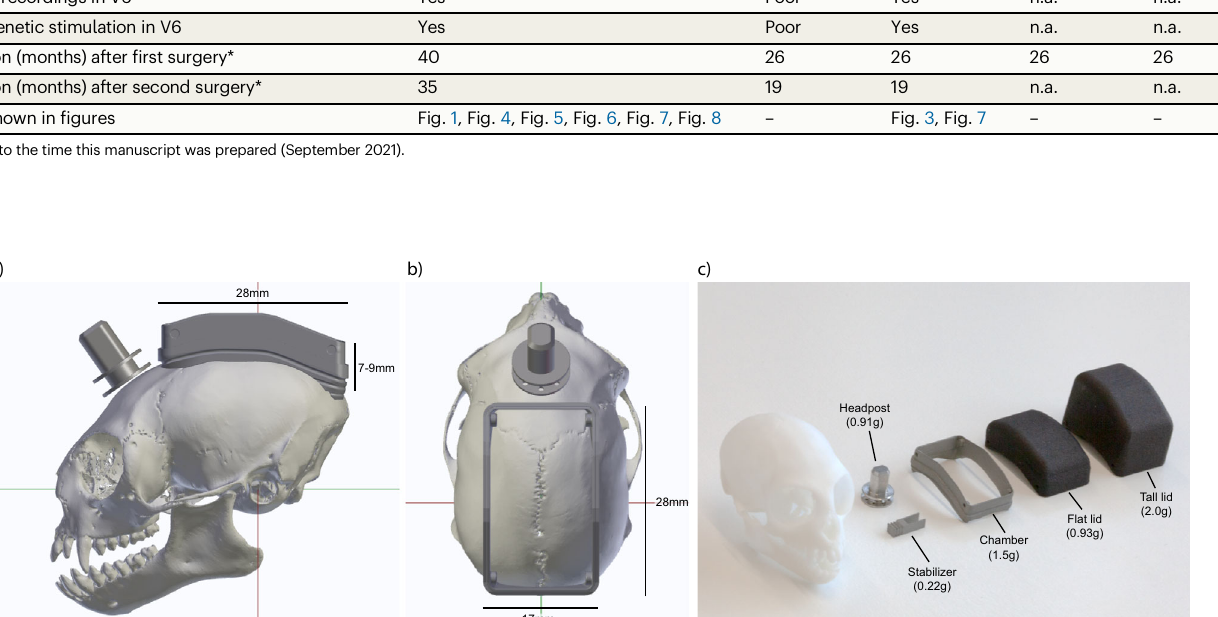
anterior – posterior axis. c Photograph of the CNC-machined and 3D-printed parts of the implant next to a skull model. Weights are indicated in